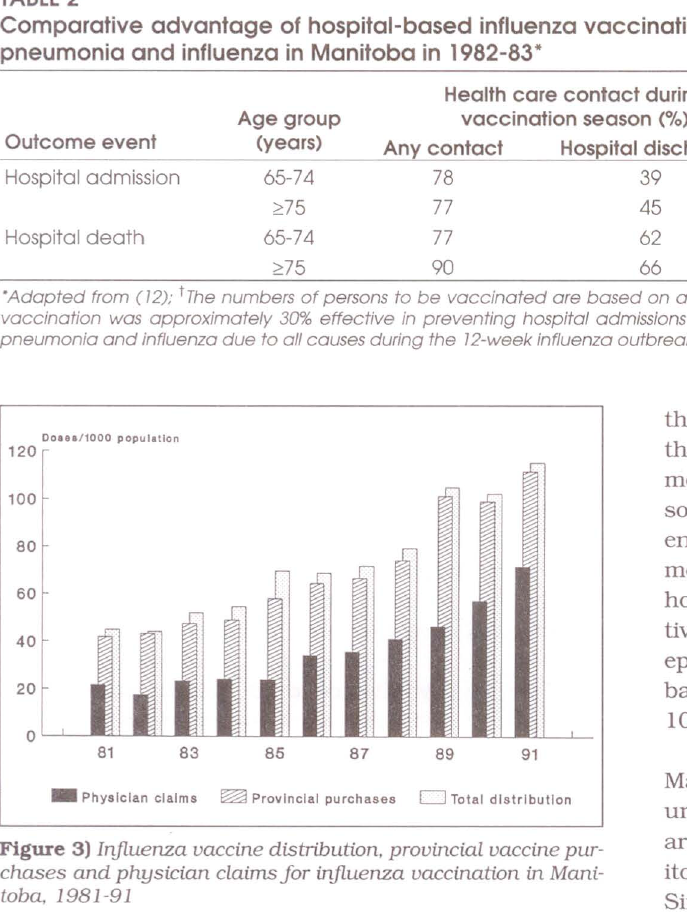
Comparative advantage of hospital-based influenza vaccination in preventing hospital admissions and deaths with pneumonia and influenza in Manitoba in